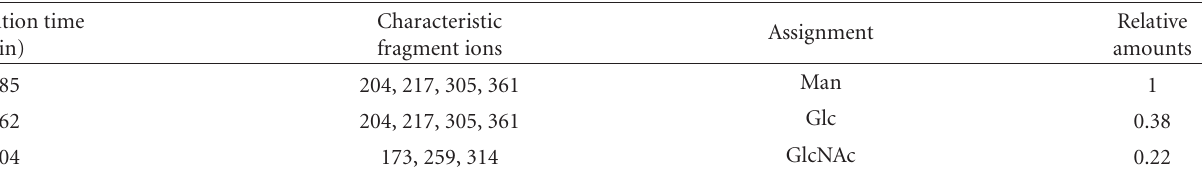
Table 2: GC-MS analysis of TMS methyl glycoside sugar derivatives obtained from S. acidocaldarius S-layer glycoprotein. Note that for experimental reasons GlcNAc recoveries are always poor in sugar analysis experiments. We consider it likely that this is the reason for the GlcNAc:Mannose ratio being much lower than expected from the LC-ES/MS/MS data, although we cannot rule out the possibility that other mannose-containing polymers are present in the sample.